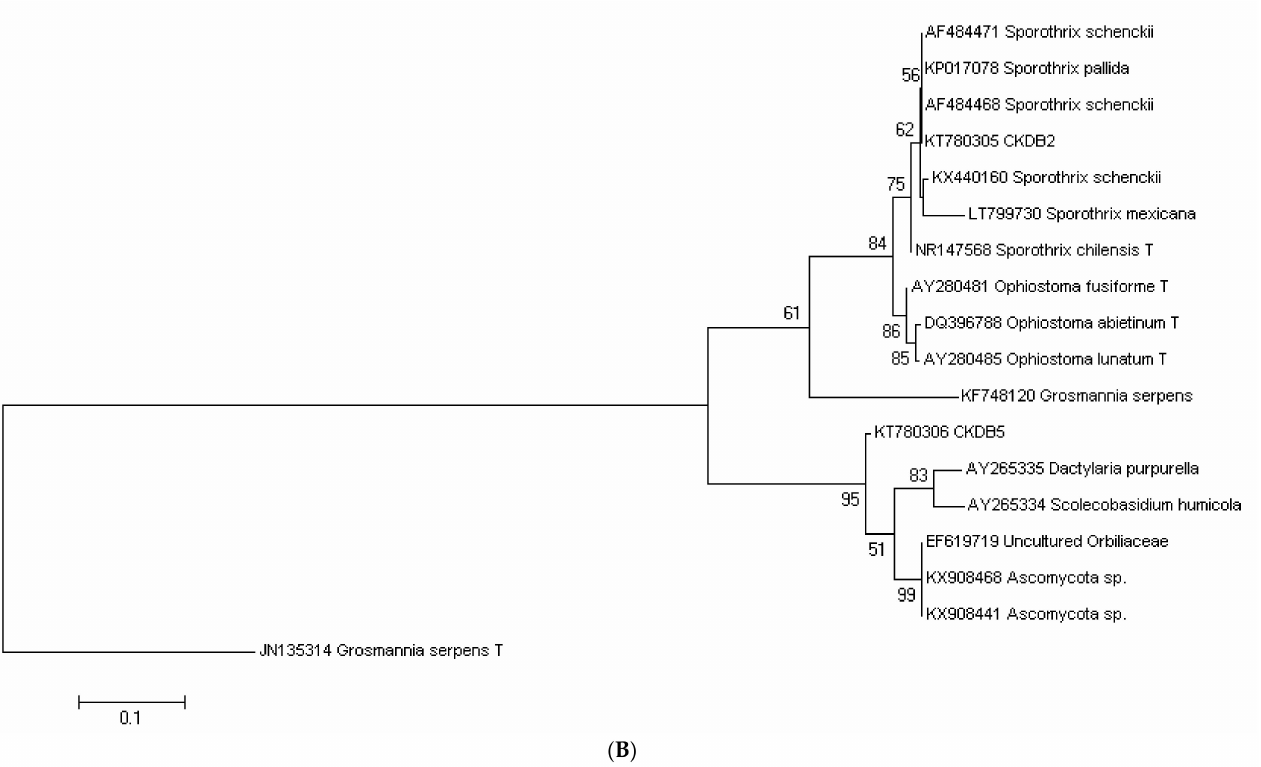
Figure 1. Maximum likelihood phylogenetic tree based on rDNA internal transcribed spacer sequence data from fungal strains MoAL2, MoAL5 ( A ), CkDB2 and CkDB5 ( B ). Bootstrap values greater than 50% are shown above or below branches.